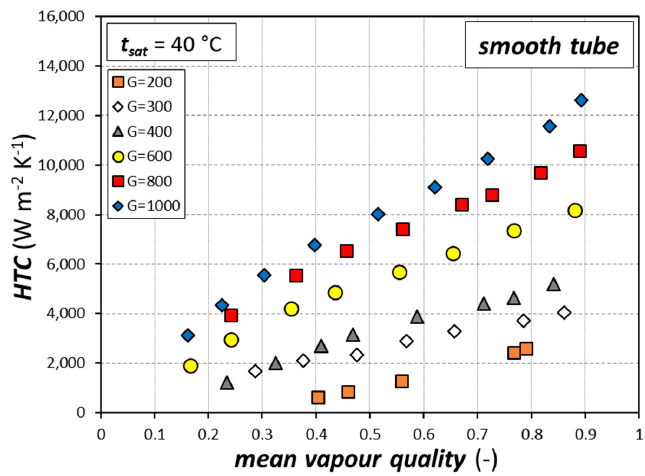
Figure 4. Heat transfer coefficient during condensation for the smooth tube vs. mean vapor quality at t sat = 40 °C. G expressed in [kg m − 2 s − 1 ].